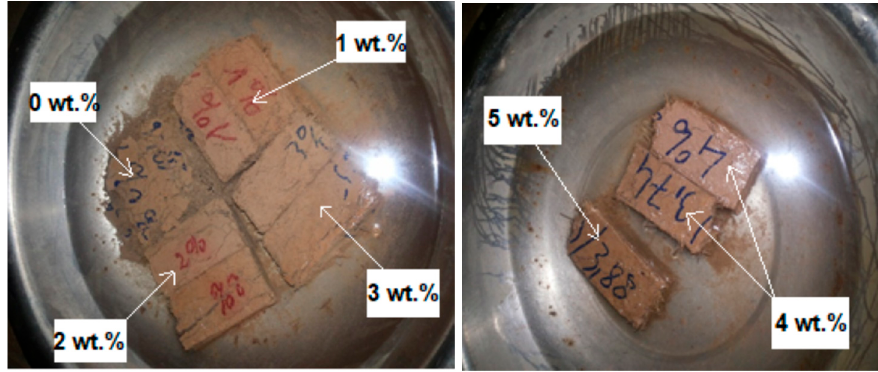
Figure 12. Adobes after 96 h of immersion.